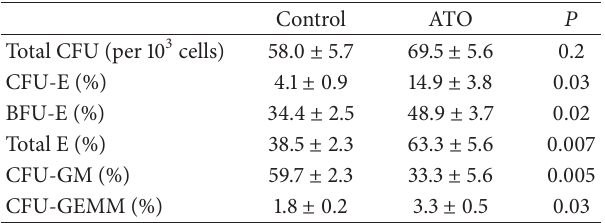
Table 1: Effects of ATO pretreatment on colony forming activities of human BM CD34+